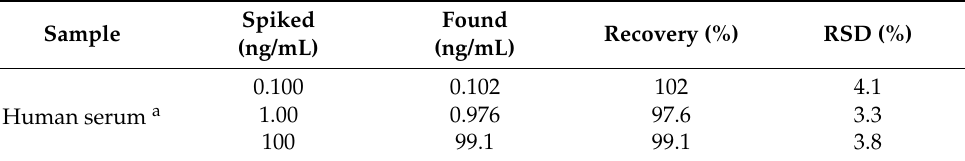
Table 2. Determination of CRP in human serum samples. Sample